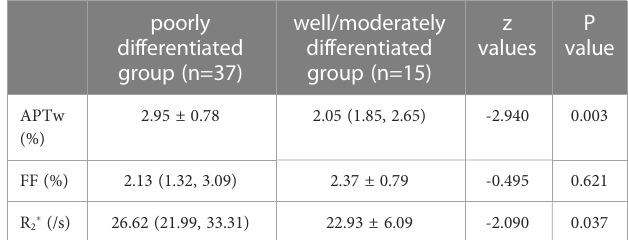
TABLE 4 Comparison of APTw and mDixon-Quant parameters between the two groups. poorly differentiated